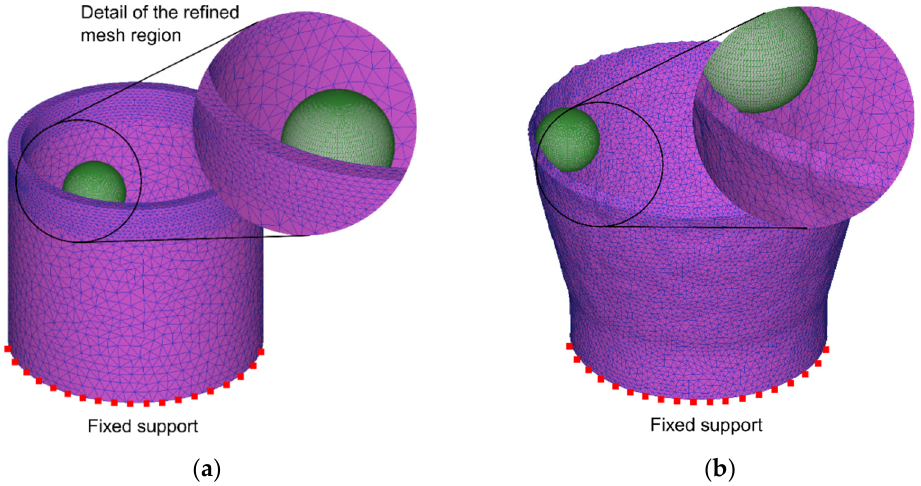
Figure 7. Finite element modeling of incremental tube expansion. ( a ) Initial mesh and ( b ) final mesh after eight forming stages.